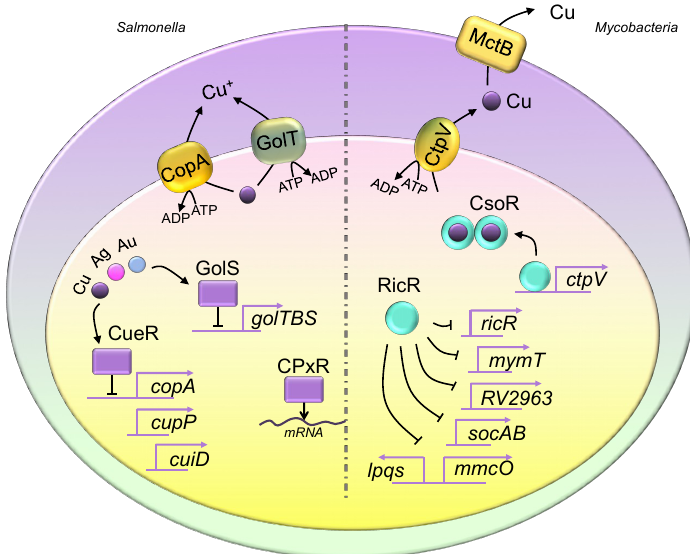
Figure 1. Copper homeostasis in Salmonella and Mycobacteria . The Salmonella genome encodes two copper exporter genes, and they produce two P-type ATPase copper efflux transporters, CopA and GolT. Both copper exporters pump copper from the cytosol into the periplasmic space. The expression of copA is regulated by CueR, which is a transcriptional repressor, and it is activated upon copper binding. CueR also controls the expression of cueP and cuiD . The translation of cueP is controlled by CpxR, which recruits RNA polymerase. The expression of the golTBS regulon is controlled by GolS. Similar to CueR, GolS responds to elevated copper levels. Additionally, both GolS and CueR sense other metals such as gold and silver. Mycobacteria utilize CtpV and mycobacterial copper transporter protein B (MctB) to eliminate intracellular copper, where CtpV pumps copper from the cytosol into the periplasmic space, and MctB pumps copper extracellularly. The two copper regulatory mechanisms are the CsoR and RicR systems. Similar to those seen in Salmonella , CsoR and RicR are transcriptional